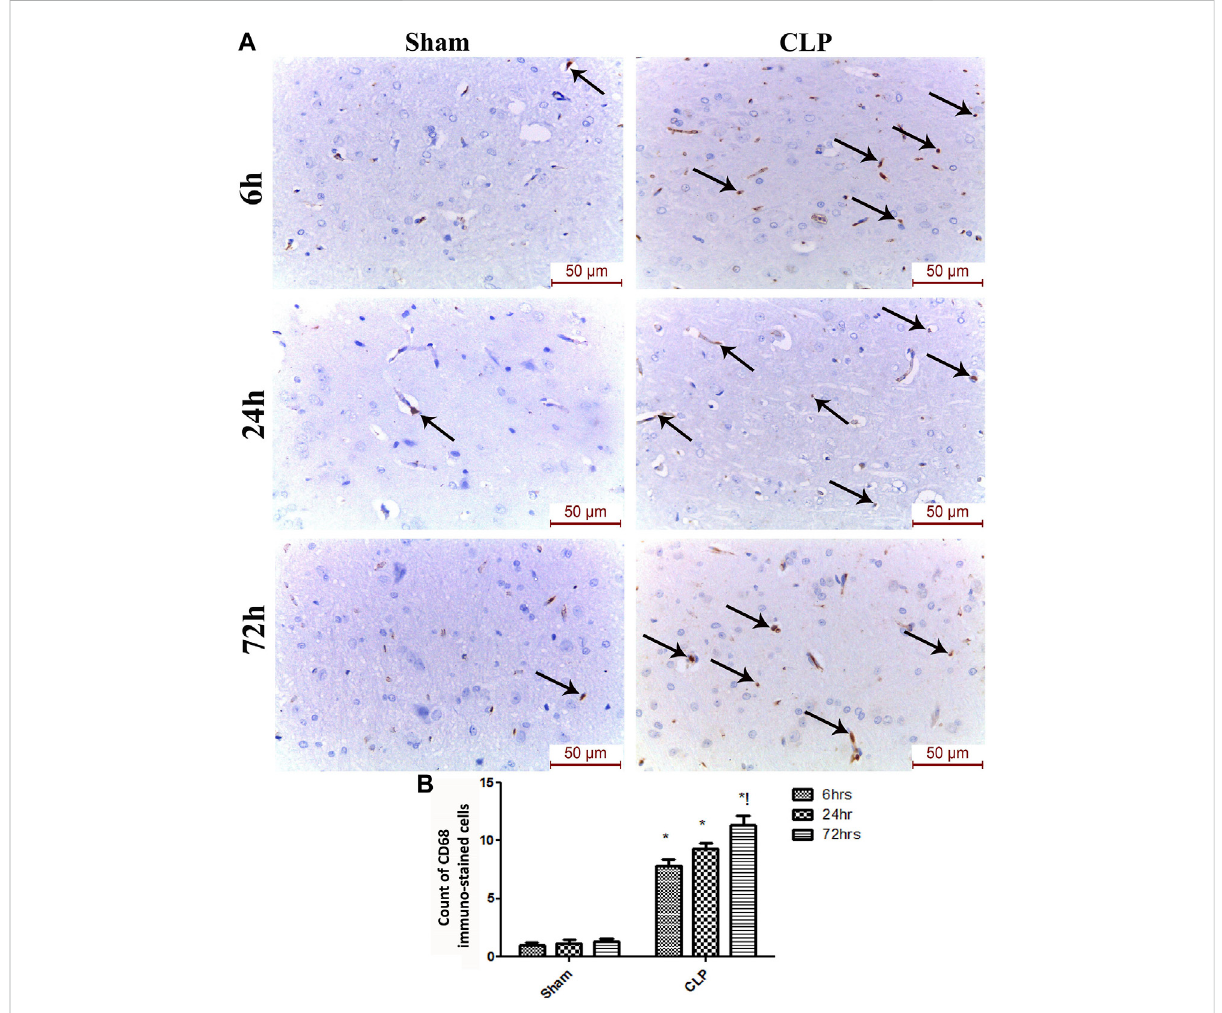
FIGURE 5 Sepsis enhanced the in fi ltration of CD 68 macrophages in brain tissues. (A) Representative images of CD68 immunohistochemical staining in the sham and cecal puncture and ligation (CLP) groups at different time points. (B) Count of cells that were immunohistochemically stained for CD68. Data are presented as the mean ± S.E.M. ( n = 6). *: Statistically signi fi cant vs. the Sham; !: signi fi cant vs. 6 h CLP; #: signi fi cant vs. 24 h CLP; as assessed using ANOVA with the Bonferroni post-hoc